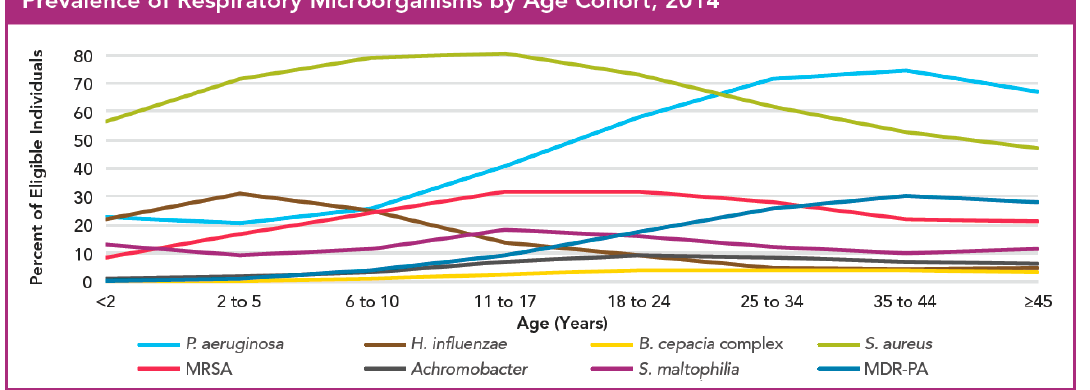
Figure 1. Prevalence of respiratory pathogens in cystic fibrosis patients by age cohort in 2014. Data are retrieved from the US CF Patient Registry and represent a cross-sectional analysis of the respiratory culture samples from patients in 2014. MDR-PA: Multi-drug resistant P. aeruginosa ; MRSA: Multi-drug resistant S. aureus . Reproduced with permission from 2014 Patient Registry Annual Data Report [18].